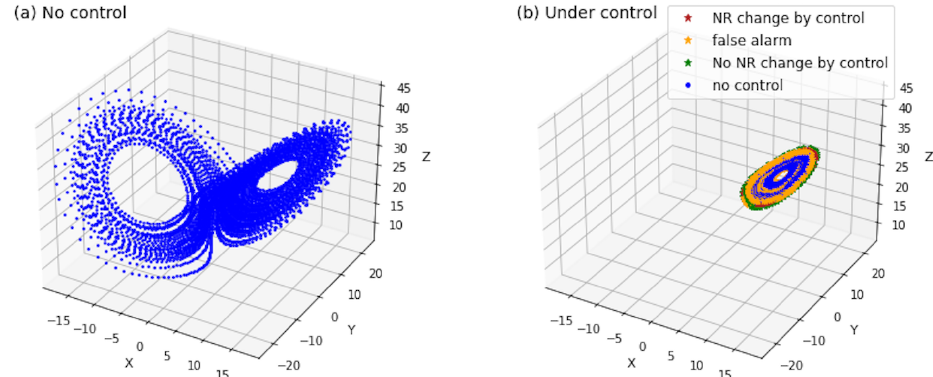
Figure 1. Phase space of the three-variable Lorenz model. (a) Lorenz’s butterfly attractor from the NR without control; (b) the NR under control ( D = 0 . 05, T = (cid:100) 4 T 0 (cid:101) ). Each dot shows every time step for 8000 steps. See also a movie at https://doi.org/10.5446/54893.